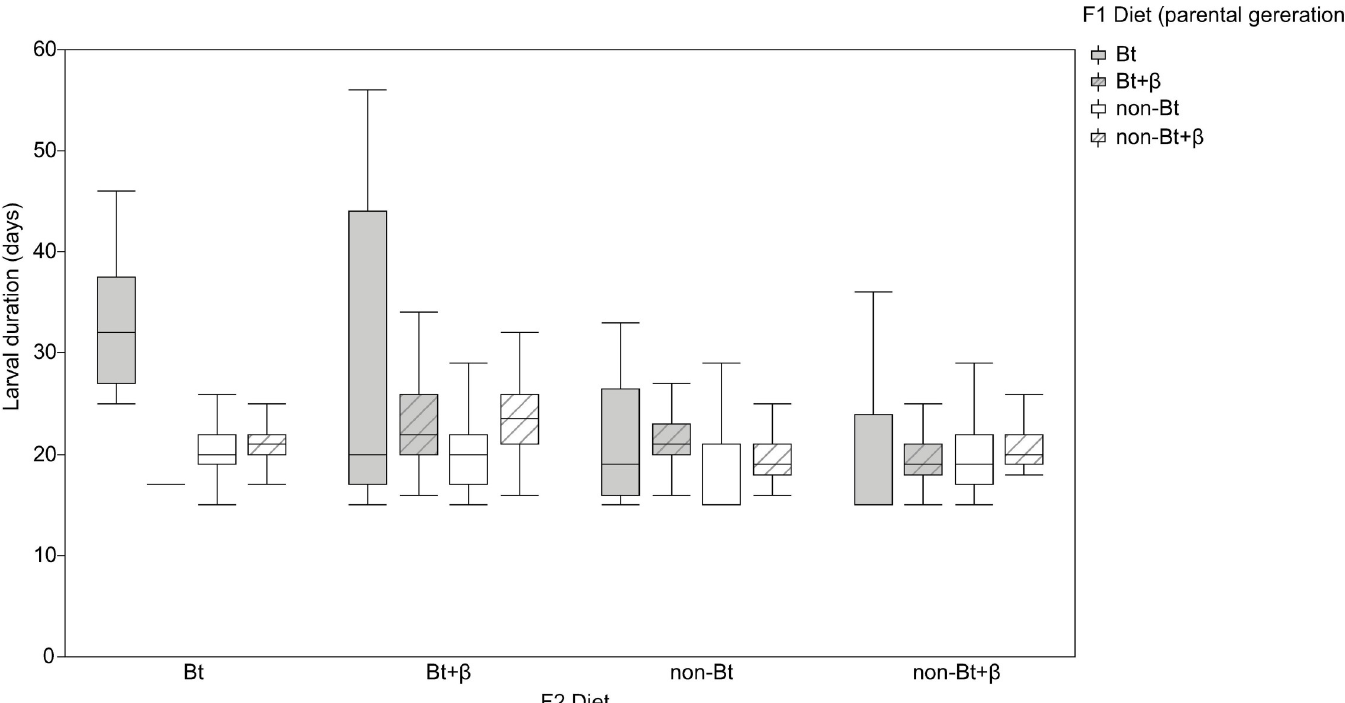
Fig 5. Development of Helicoverpa armigera F2 larvae. Larval duration (in days) of Helicoverpa armigera F2 larvae fed Bt or non-Bt diets with or without β -carotene supplementation coming from F1 larvae fed 1 of the 4 different diets. F2 diet indicates the diet of the experimental larvae; F1 diet indicates the diet of the parental larvae. Data were analyzed by a two-way ANOVA ( P < 0.005); means were compared by LSD means. https://doi.org/10.1371/journal.pone.0269585.g005 (Fig 7). β -carotene ( χ 2 = 0.20488; P < 0.6508), and the interaction ( χ 2 = 1.08321; χ 2 < 0.298) did not affect the mortality. P χ 2